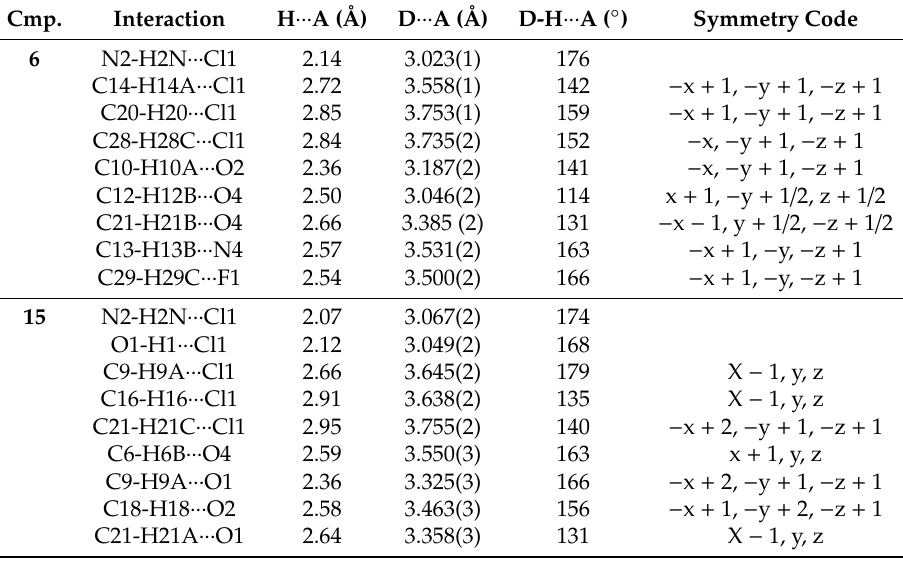
Table 2. Parameters of intermolecular interactions for 6 and 15